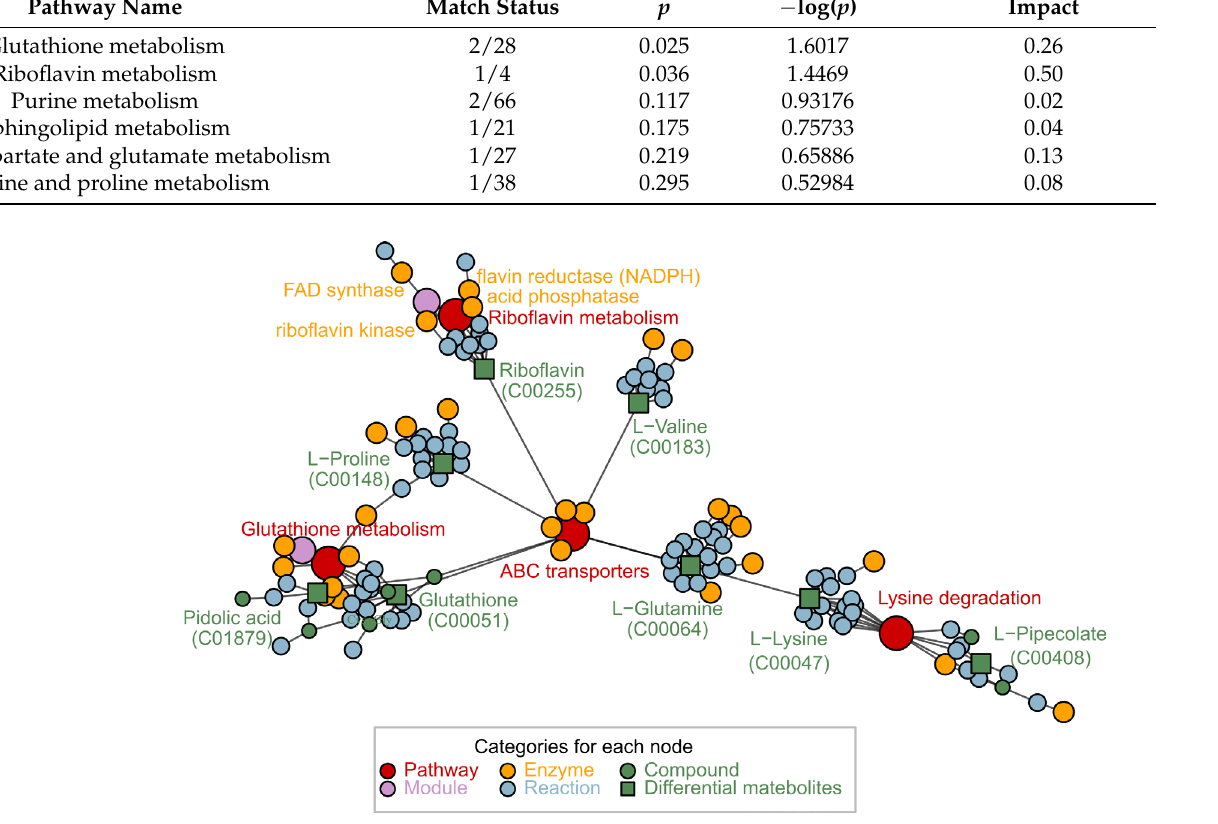
Figure 4. Network diagram related to differentially expressed metabolic pathways after GRb1 treat- ment by FELLA.